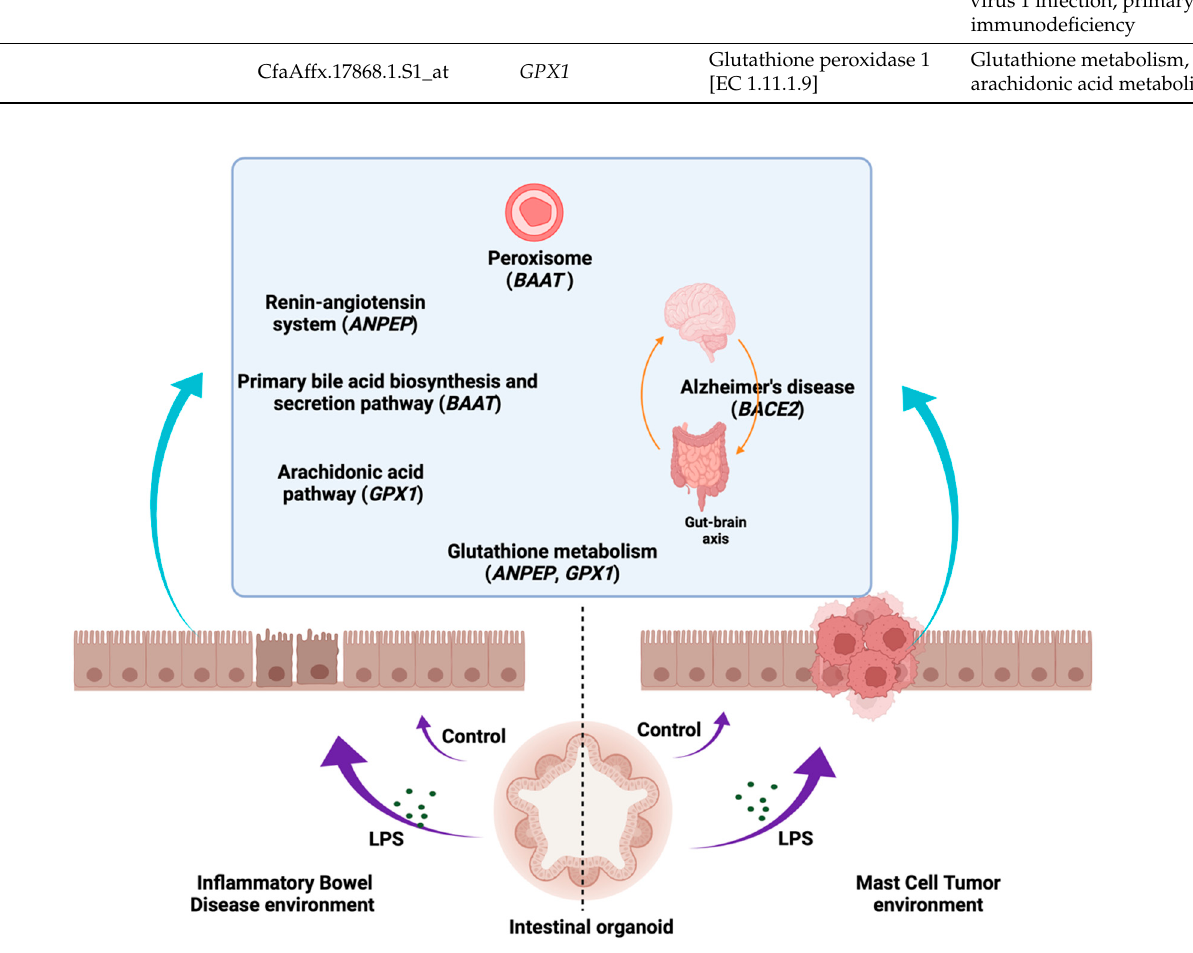
Figure 11. The association of several metabolic pathway genes in the IBD intestinal organoids and tumor enteroids. The figure was created with BioRender.com.